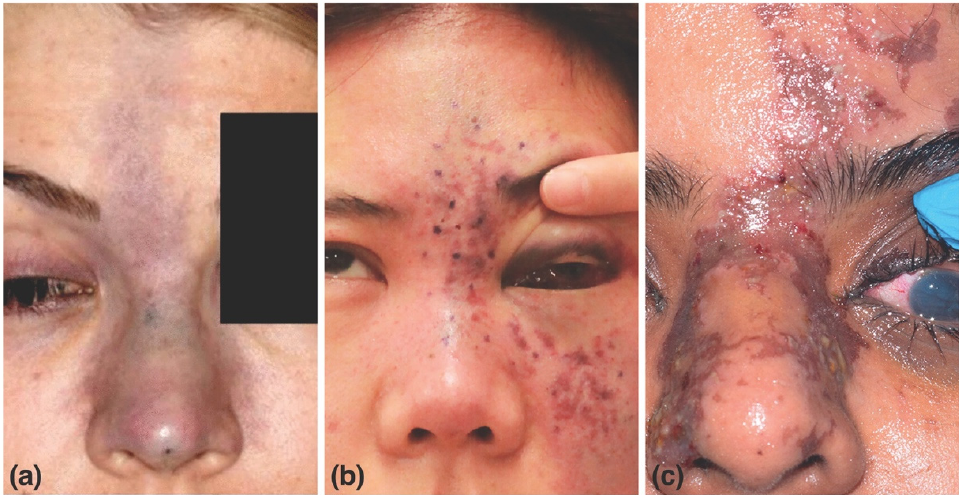
Figure 14. Diversity of ischemic skin patterns of the upper face following accidental vascular occlusion with hyaluronic acid (HA) gel filler. ( a ) Early ischemic changes (livedo reticularis) hours after dorsal nasal injection, showing involvement of the right supratrochlear territory, paracentral vessels, and dorsal nasal arterial regions; used with permission from Lucaciu et al. [187]. ( b ) Early ischemic changes 6 h following glabellar HA filler injection, demonstrating involvement of the left supratrochlear artery, paracentral vessels, dorsal nasal territories, and infraorbital region; used with permission from Xu et al. [188]. ( c ) Ischemic skin changes 24 h following accidental vascular occlusion resulting from nasal dorsal augmentation with HA filler, showing involvement of the left supratrochlear, left supraorbital, and bilateral dorsal nasal arteries; used with permission from Eldweik [193].